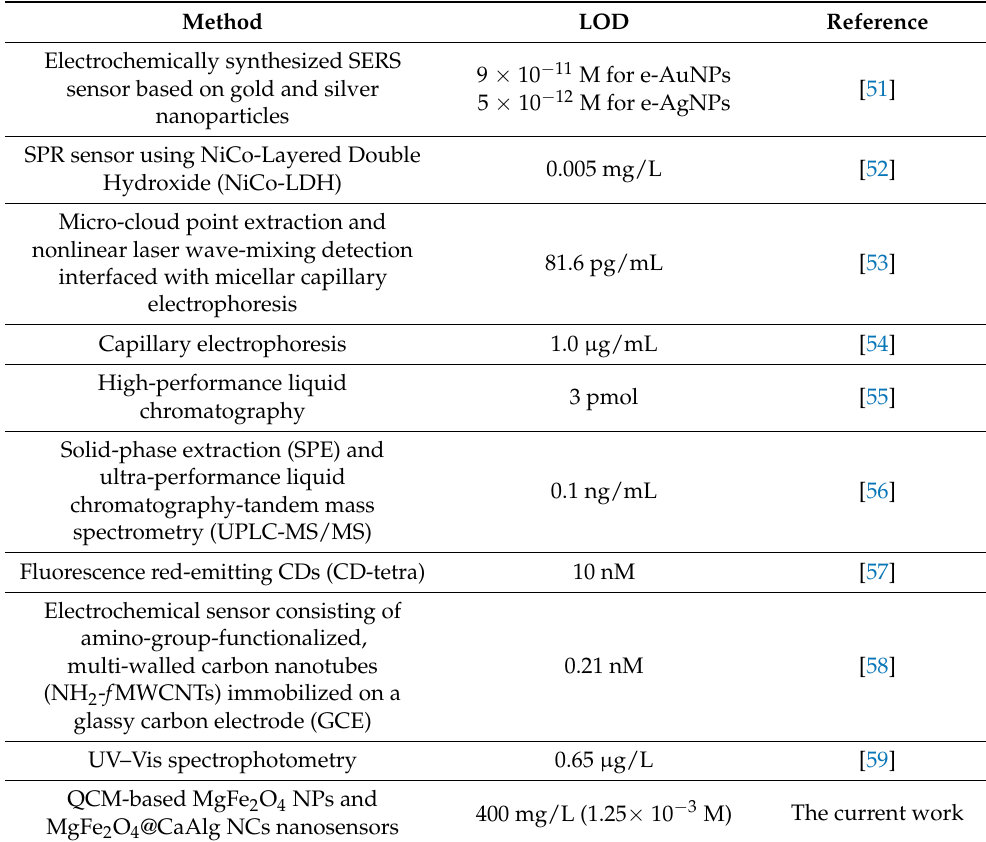
Table 1. Comparison of the QCM-based MgFe 2 O 4 NPs and MgFe 2 O 4 @CaAlg NCs nanosensors method with other methods for detecting MB